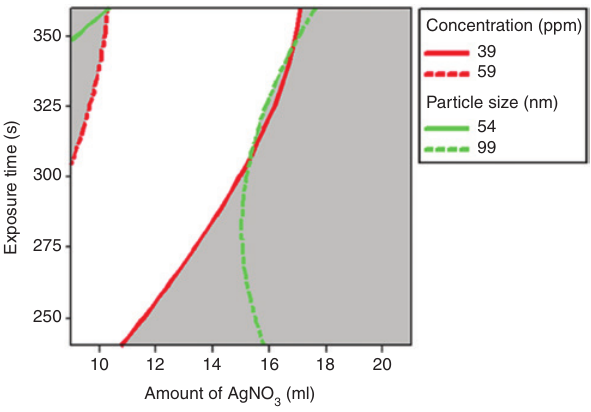
Figure 6: UV-Vis spectra of the mixture solution containing AgNO and Aloe vera extract, after synthesis with exposure to microwave irradiation at obtained optimum synthesis